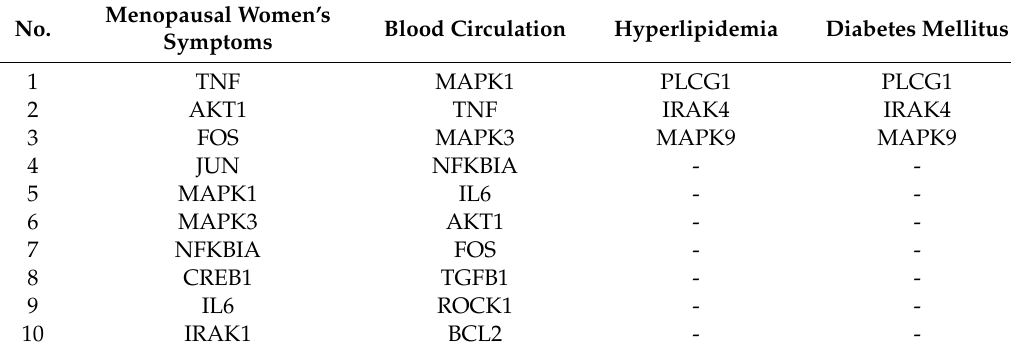
Table 1. Top 10 targets of red ginseng in metabolic